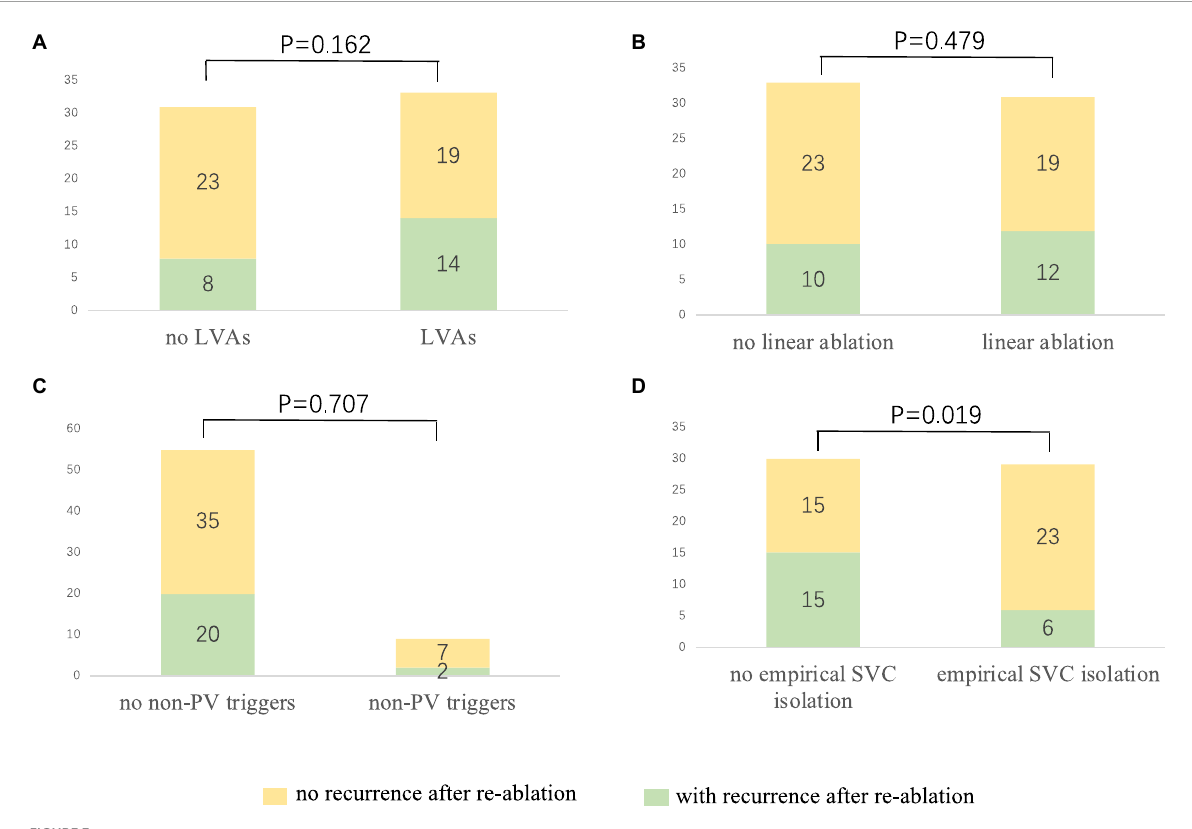
FIGURE3 The relationship between procedure characteristics and the re-ablation outcome. (A) No significant difference could be observed among the patients with and without LVAs (42.4 vs. 25.8%, p = 0.162). (B) Linear ablation did not improve the outcome of the redo procedure (38.7 vs. 30.3%, p = 0.479). (C) No significant difference could be identified among the patients with and without confirmed non-PV triggers (36.4 vs. 22.2%, p = 0.707). (D) Empirical SVC isolation improved the re-ablation outcome (20.7 vs. 50%, p = 0.019). LVA, low voltage area; PV: pulmonary vein; SVC, superior vena